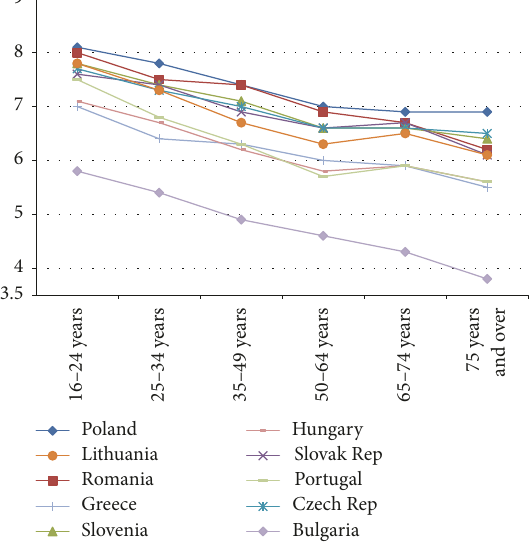
that life satisfaction decreased in western European countries and increased in central-eastern European countries. How- ever, some considerable differences exist between countries. Mean life satisfaction decreased with at least 0,5 points in Cyprus, Denmark, Estonia, and Malta but increased with at least 0,5 points in Austria, Hungary, Latvia, and